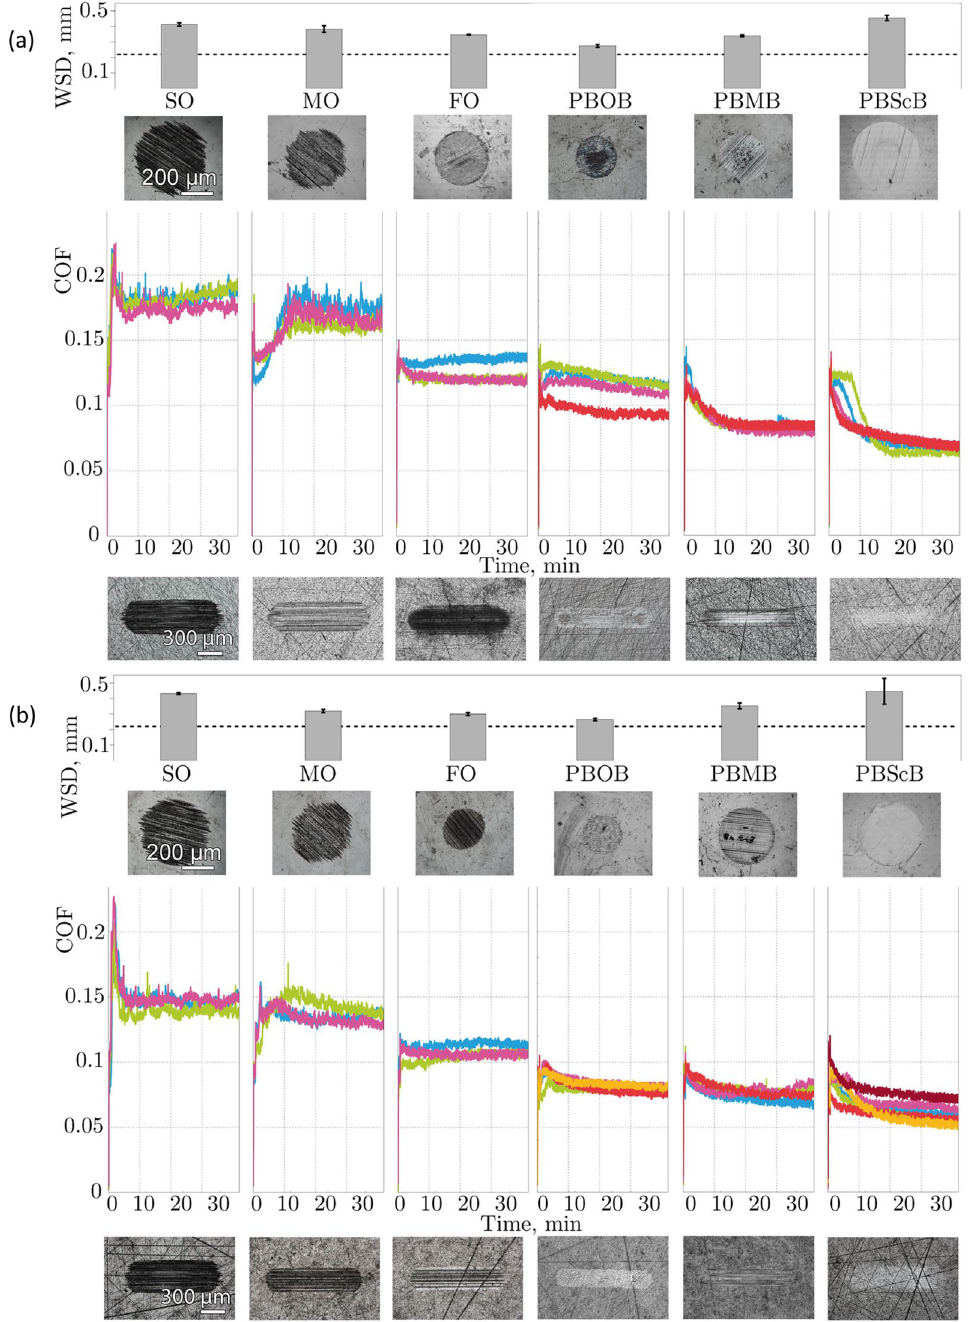
Figure 5. Ball wear scar diameters (WSDs), friction traces and optical images of the wear scars on the ball and either (a) SD surfaces or (b) BW surfaces for constant load tests involving the lubricants shown. Different coloured traces represent different replicate experiments. The dashed lines in the WSD plot indicate the initial Hertzian contact